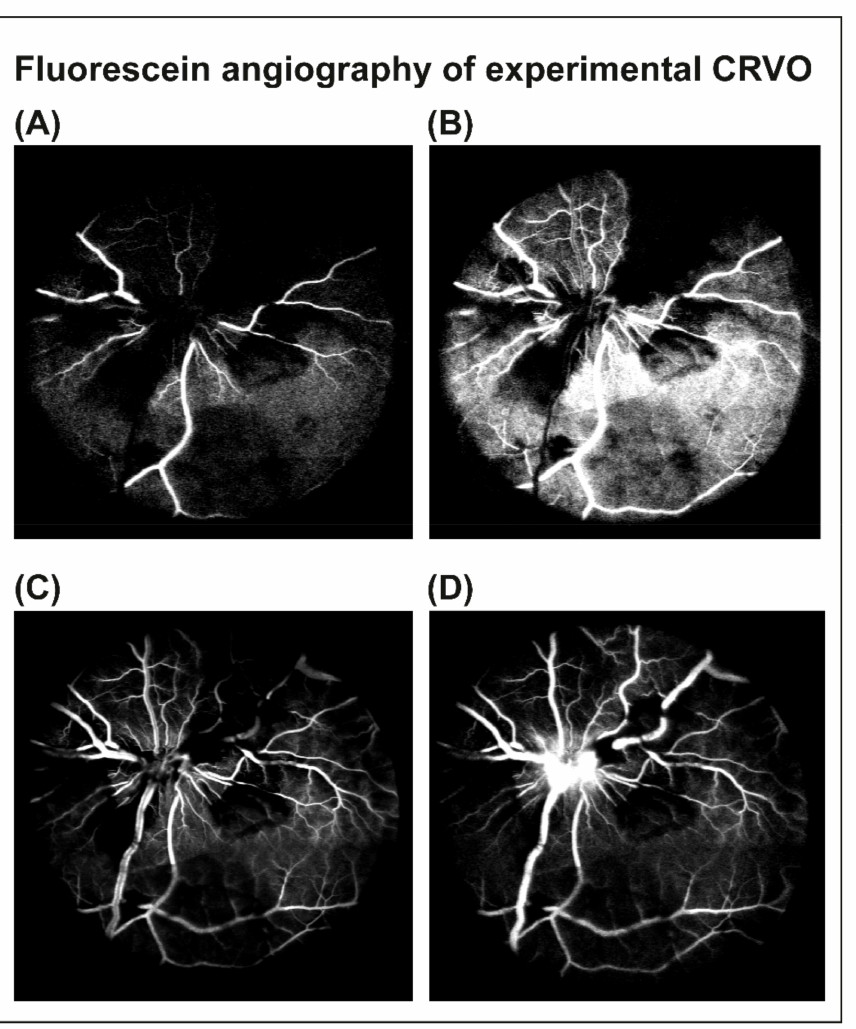
Figure 2. Fluorescein angiography was performed 3 days after CRVO to confirm that the occlusion was successfully induced. ( A – C ) Early phases of fluorescein angiography of experimental CRVO at 15–24 s. Angiography revealed tortuous retinal veins, delayed venous filling and retinal capillary non-perfusion following CRVO. ( D ) Angiography at 1 min and 26 s. Venous dilation, retinal capillary non-perfusion and leakage of fluorescein were